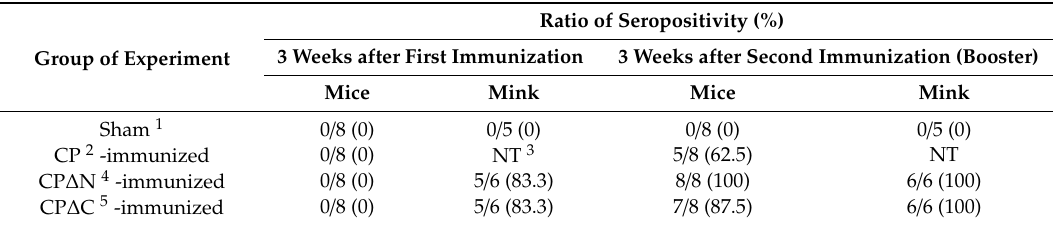
Ratio of Seropositivity